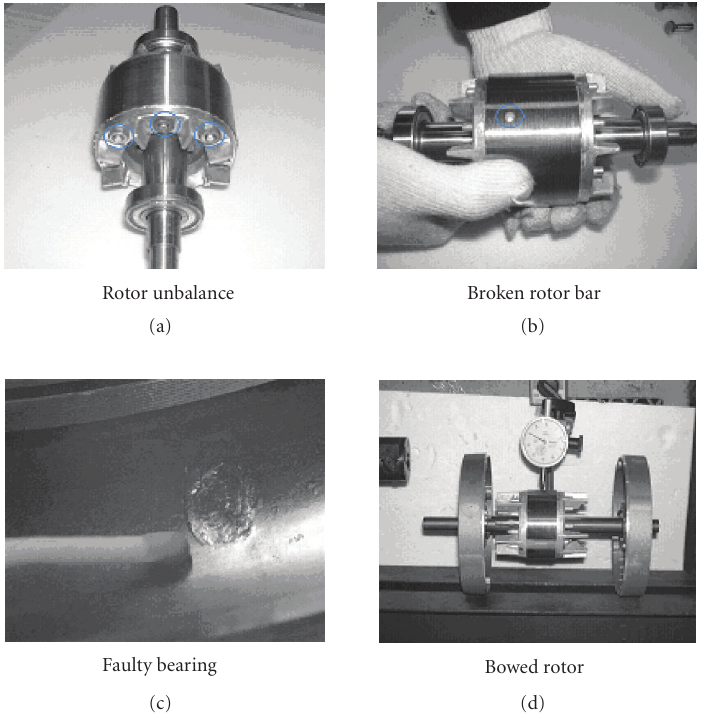
Figure 5: Faults on the induction motors.